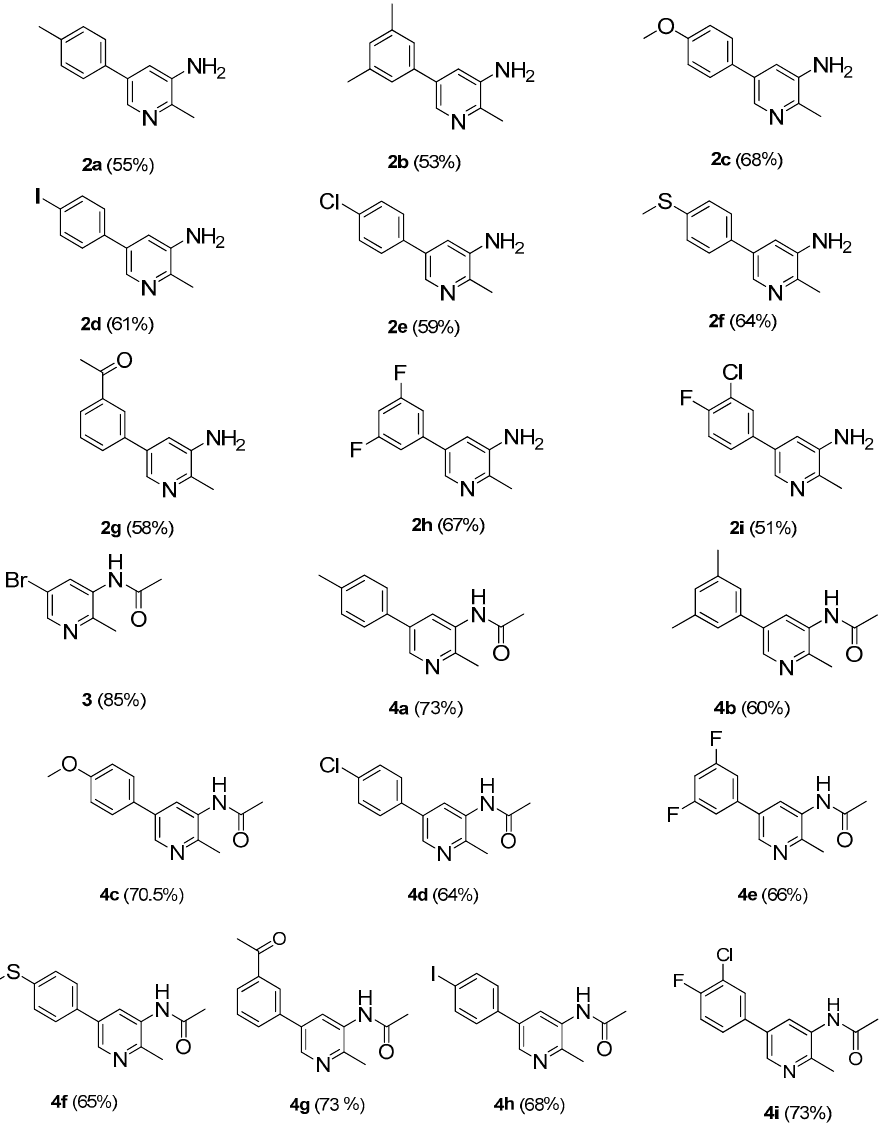
Figure 1. Structures of the newly synthesized pyridine derivatives viz . 2a – 2i , 3 , 4a – 4i